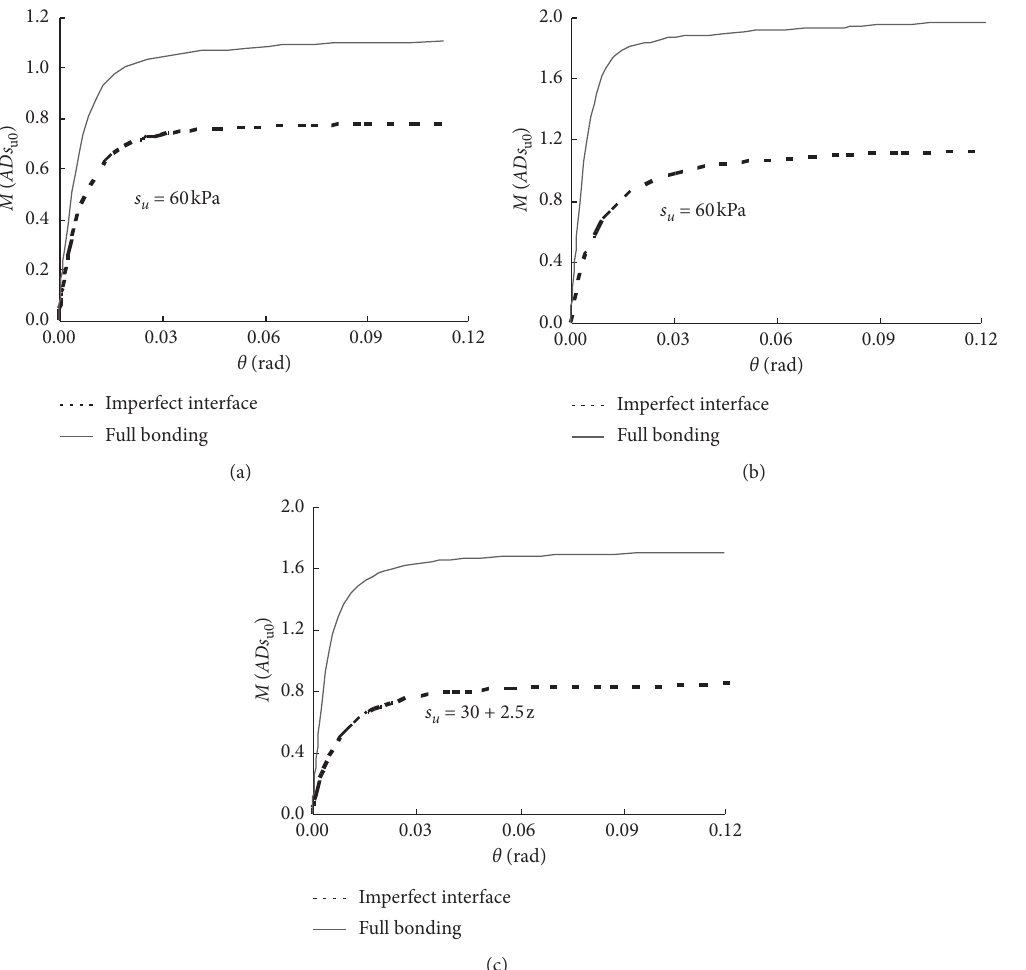
Figure 3: Relation of moment and rotation of bucket foundation subjected to monotonic loading. (a) L / D � 0.2. (b) L / D � 0.6 (homo- geneous). (c) L / D � 0.6